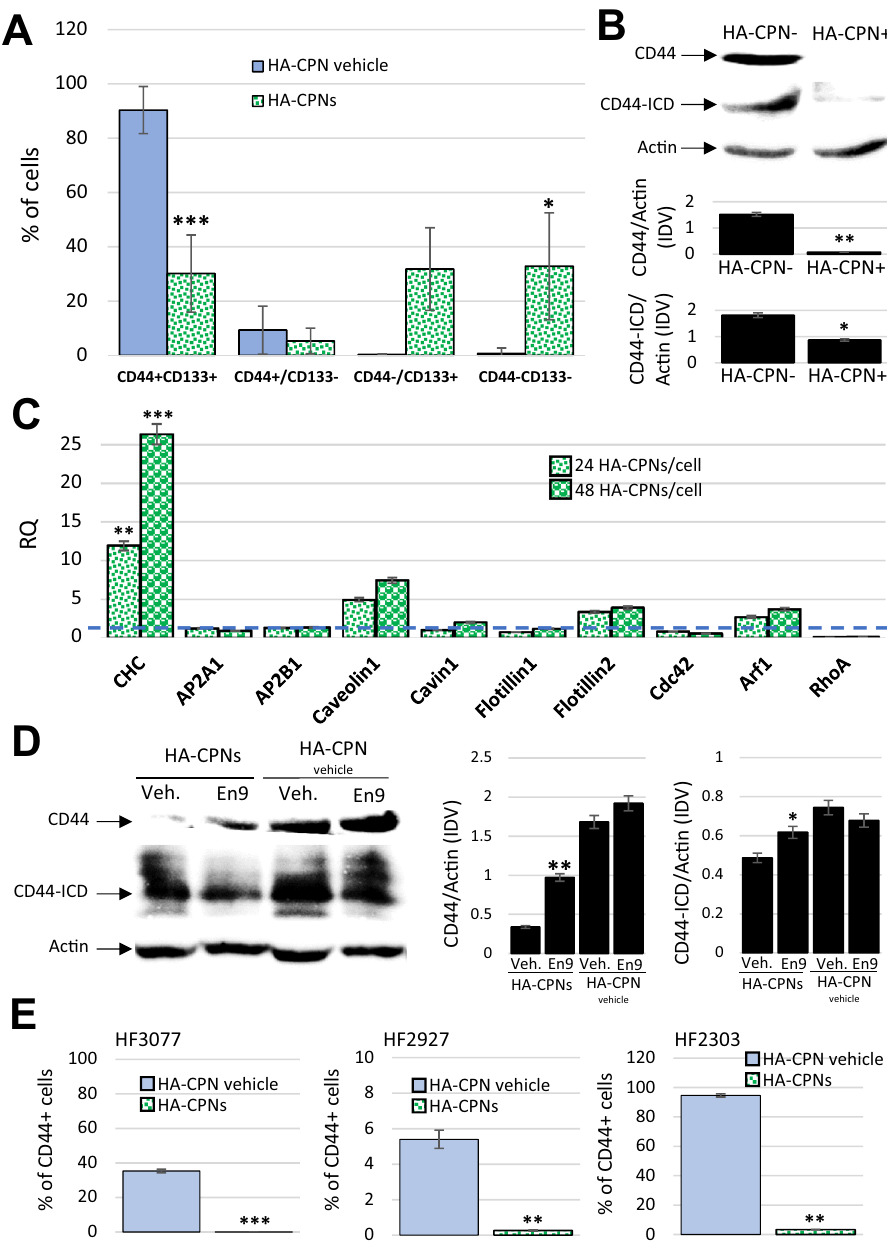
Figure 5. HA-CPNs Downregulate the Expression Levels and Signaling Activity of CD44 in GBM. ( A ) U-251 MG cells were treated with HA-CPNs and/or vehicle control (HA-CPN vehicle) and subjected to flowcytometry analysis of the indicated TIC populations; ( B ) Assessment of the protein expression levels of CD44 and CD44 intracytoplasmic domain (CD44-ICD) via Western blotting in FACS derived HA-CPN + and HA-CPN- cells (top). Protein levels quantified using densitometry and shown as ratio to Actin in Integrated Density Values (IDV) (bottom, graphs); ( C ) mRNA expression of signature markers of diverse endocytotic mechanisms in U-251 MG cells treated with 24 and/or 48 HA-CPNs/cell relative to HA-CPN vehicle control (dotted line); ( D ) CD44 and CD44-ICD protein expression levels in U-251 MG cells treated with HA-CPNs and/ or HA-CPN vehicle control in the presence of Endosidin 9 or vehicle control (left). Protein levels quantified using densitometry and shown as ratio to Actin in Integrated Density Values (IDV) (right); ( E ) Flowcytometry analysis of CD44 expression levels in the indicated GBM patient samples treated with HA-CPNs and/or HA-CPN vehicle control. Data shown as mean ± s.d, n = 3, *p < 0.05, **p < 0.01, ***p < 0.001; Student’s t -test. Original blotted membranes of Western can be found in Fig.